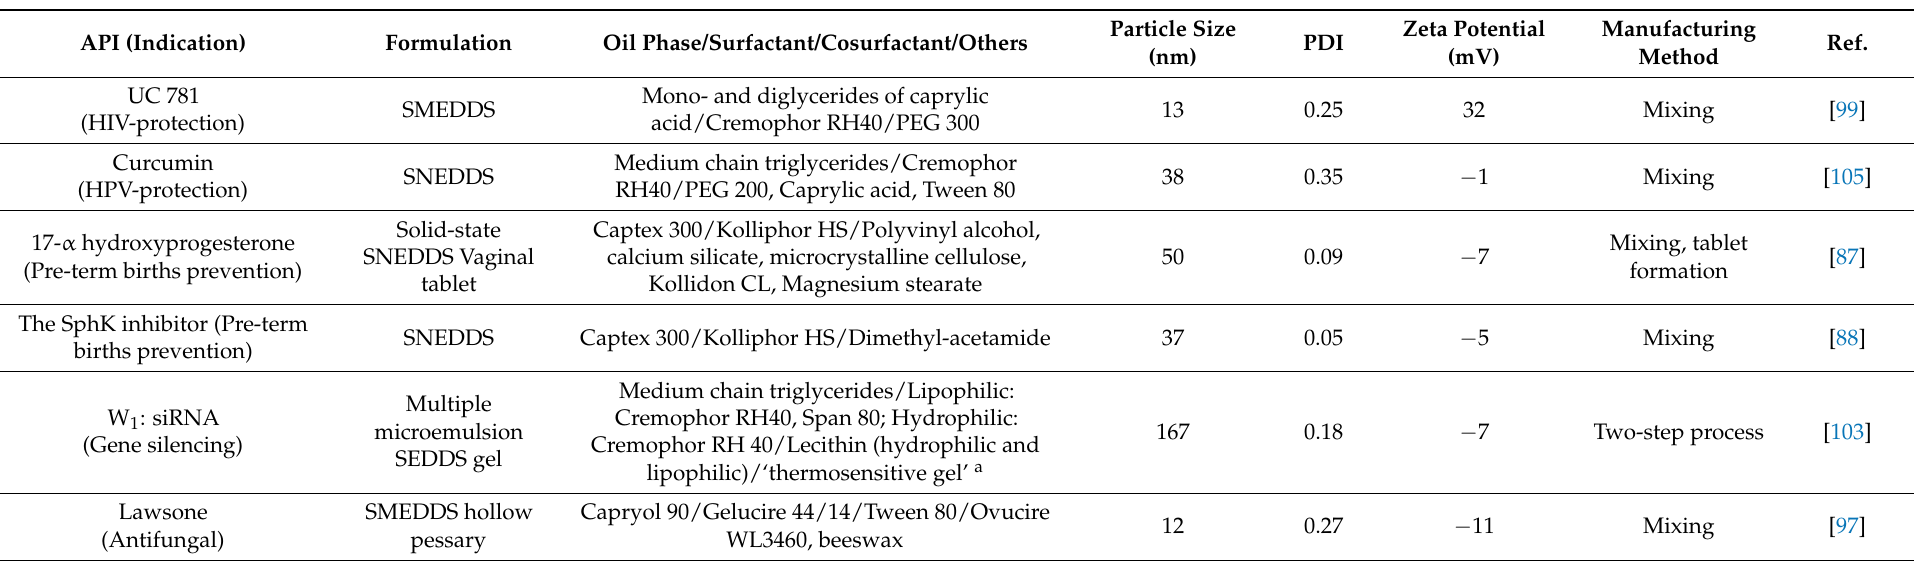
Table 6. Vaginal self-emulsifying drug delivery systems—composition, characteristic properties and manufacturing